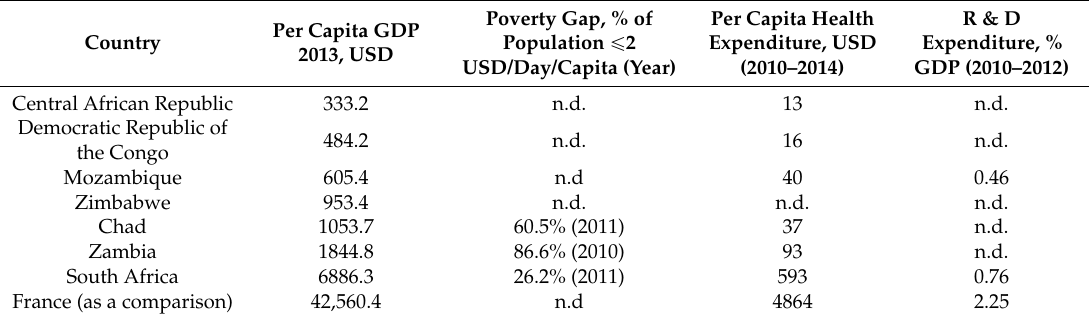
Table 1. Health and economic indicators of select sub-Saharan African countries, contrasted against France as an example of a developed European country.